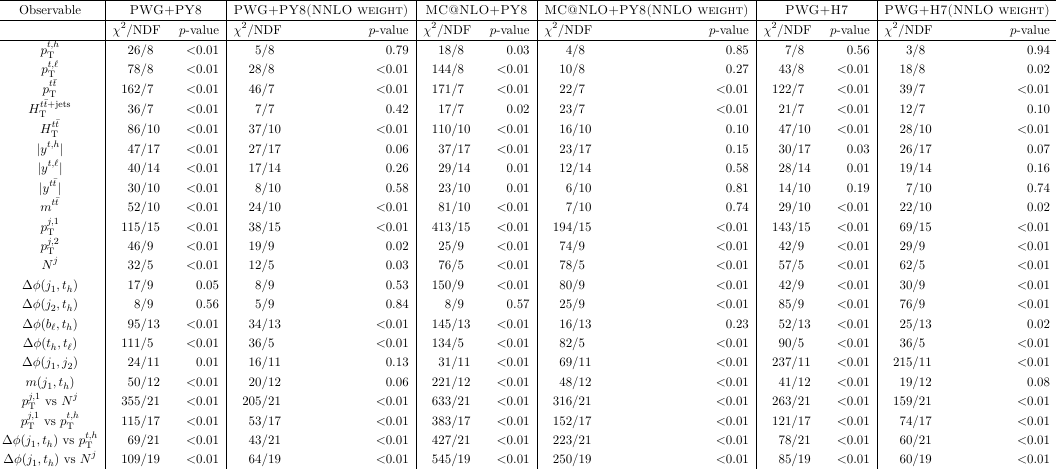
Table 3. χ 2 and p -values quantifying the level of agreement between the absolute unfolded spec- tra, several NLO+PS predictions and the respective NNLO reweighted spectrum. PWG+PY8 corresponds to the Powheg+Pythia sample, PWG+H7 to the Powheg+Herwig sample and